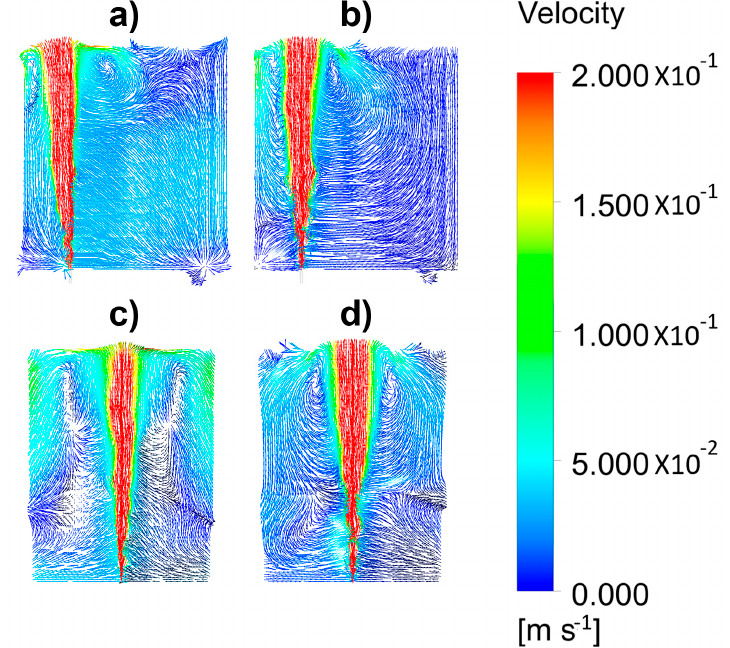
Figure 8. Simulated velocity fields of the liquid phase for a gas flow rate of 1.07 × 10 − 4 m 3 /s and different thicknesses of the oil layer. Front view ( a ) 0.02 m and ( b ) 0.04 m. Side view ( c ) 0.02 m and ( d ) 0.04 m.